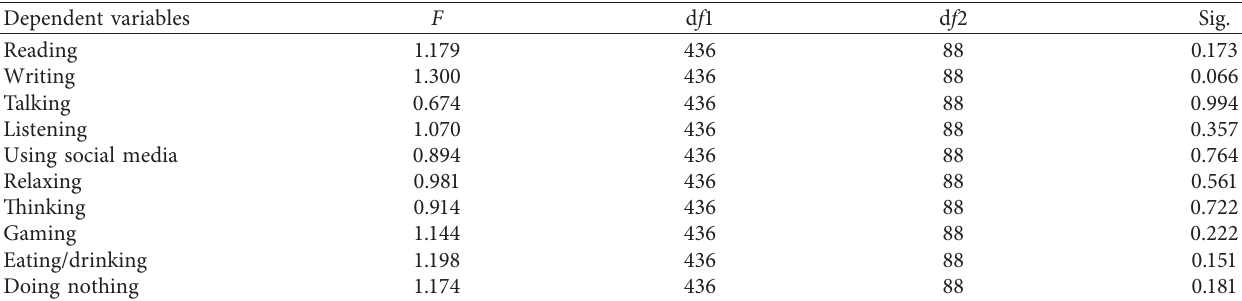
Table 8: Levene’s test of equality of error variances of onboard activities a